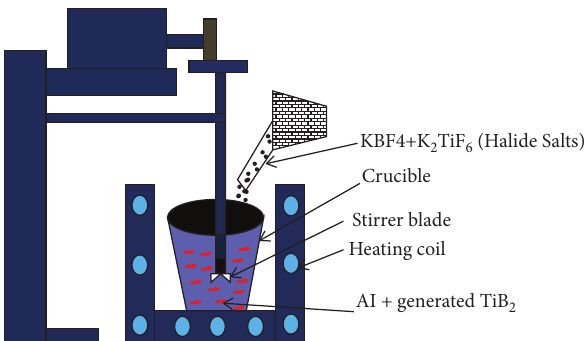
Figure 12: Experimental arrangement of Al-TiB